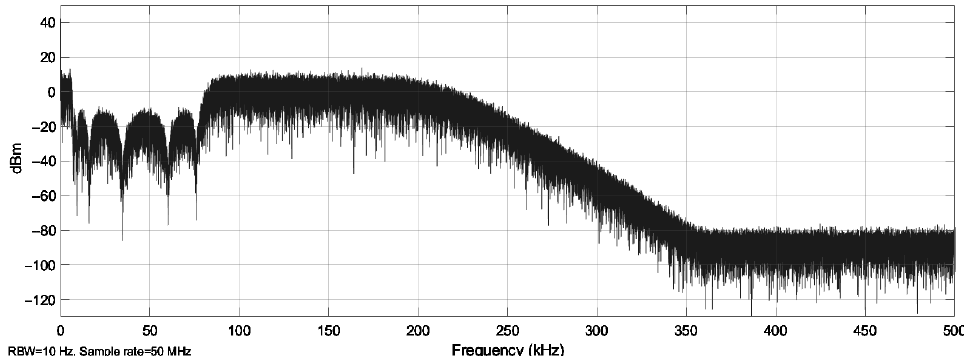
Figure 15. The spectrum of the filter system unit output signal with white noise applied to the input.